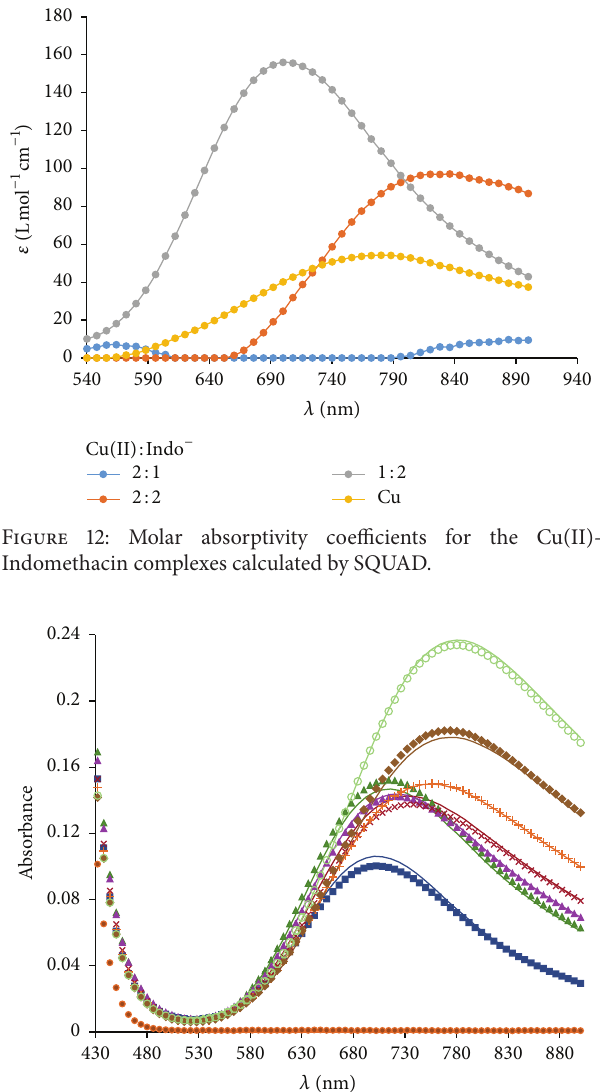
Figure 11: Species distribution diagram of the system Cu(II)- Indomethacin in ethanol, the formation constants are shown in Table 1.